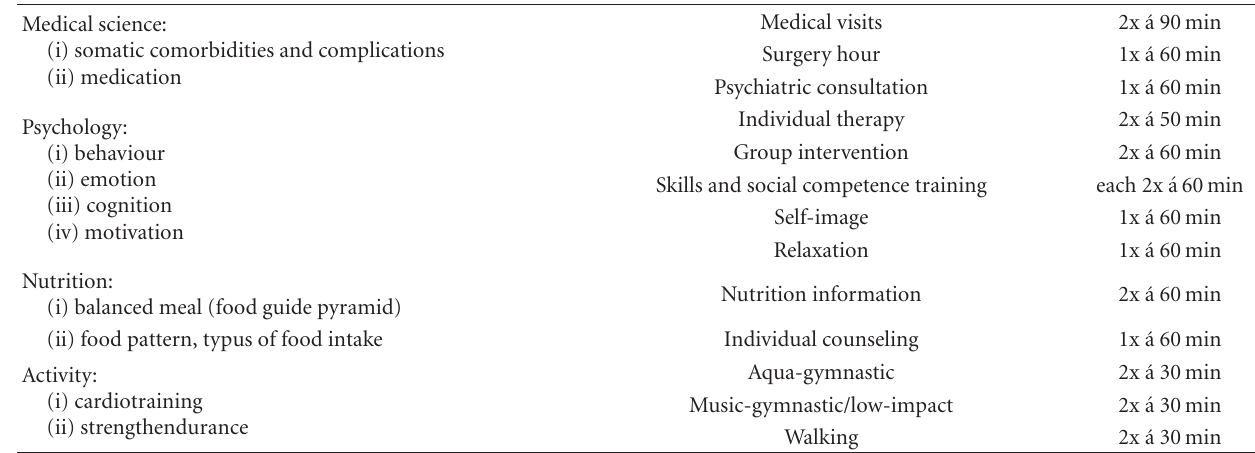
Table 2: Weekly timetable of interventions of the “schwerelos”